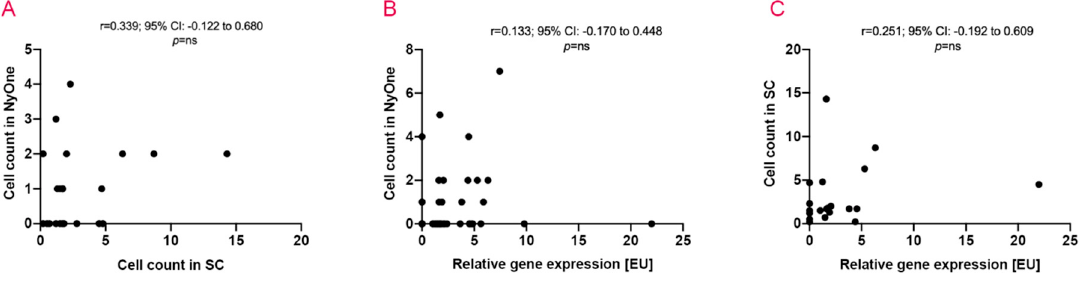
Figure 4. Correlation of the utilised detection methods and CTC quantity. Data obtained by each mode of detection for the CTC quantity were inter-correlated to the other technique. ( A ) NYONE ® vs ScreenCell ® (SC). ( B ) NYONE ® vs CK20-RT-qPCR. (C) CK20 RT-qPCR vs ScreenCell ®